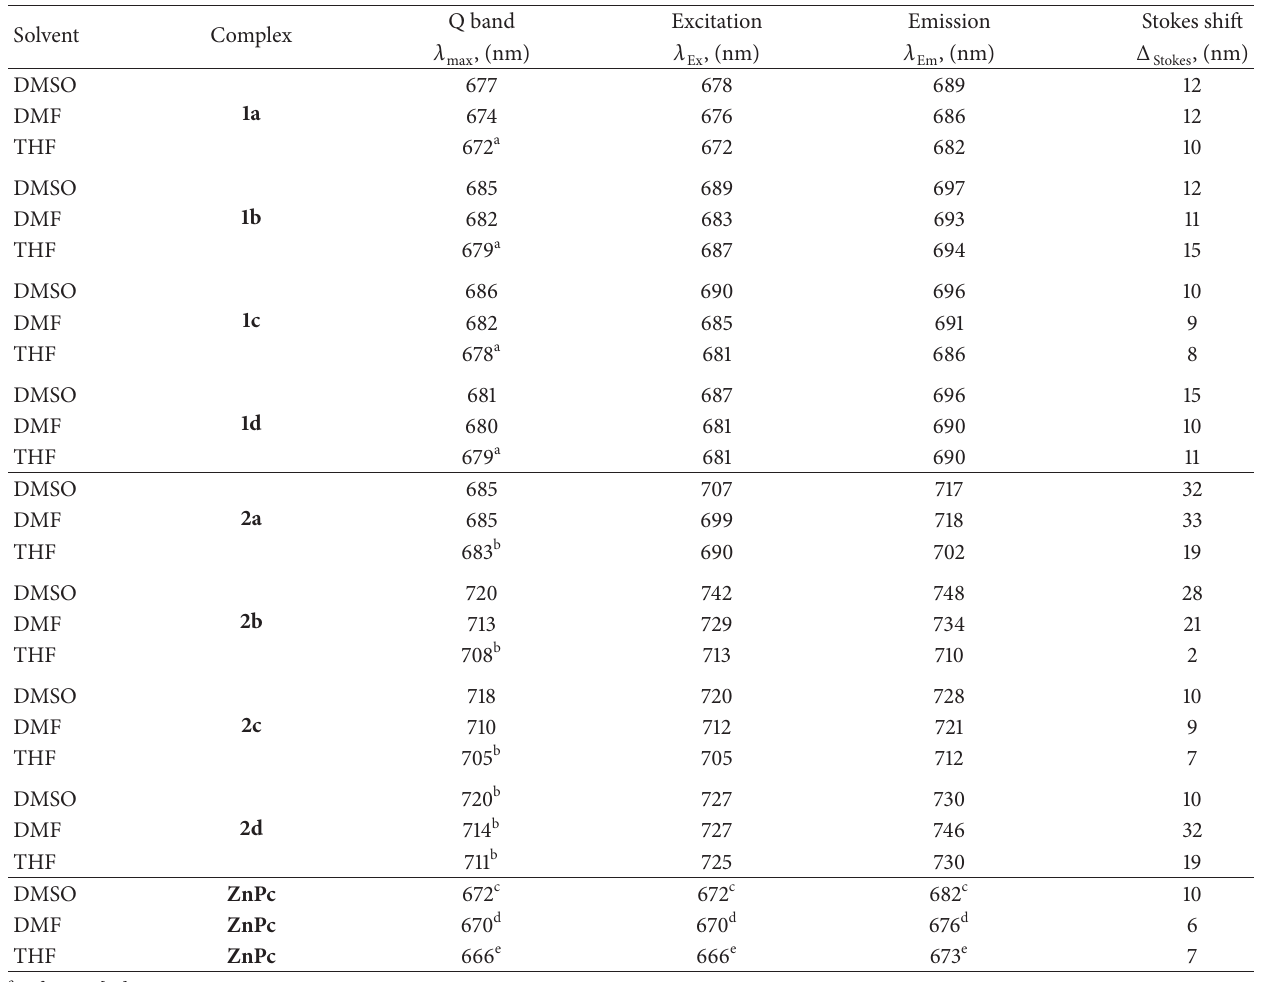
Table 1: Spectral parameters of 1a – 1d and 2a–2d in DMSO, DMF, and